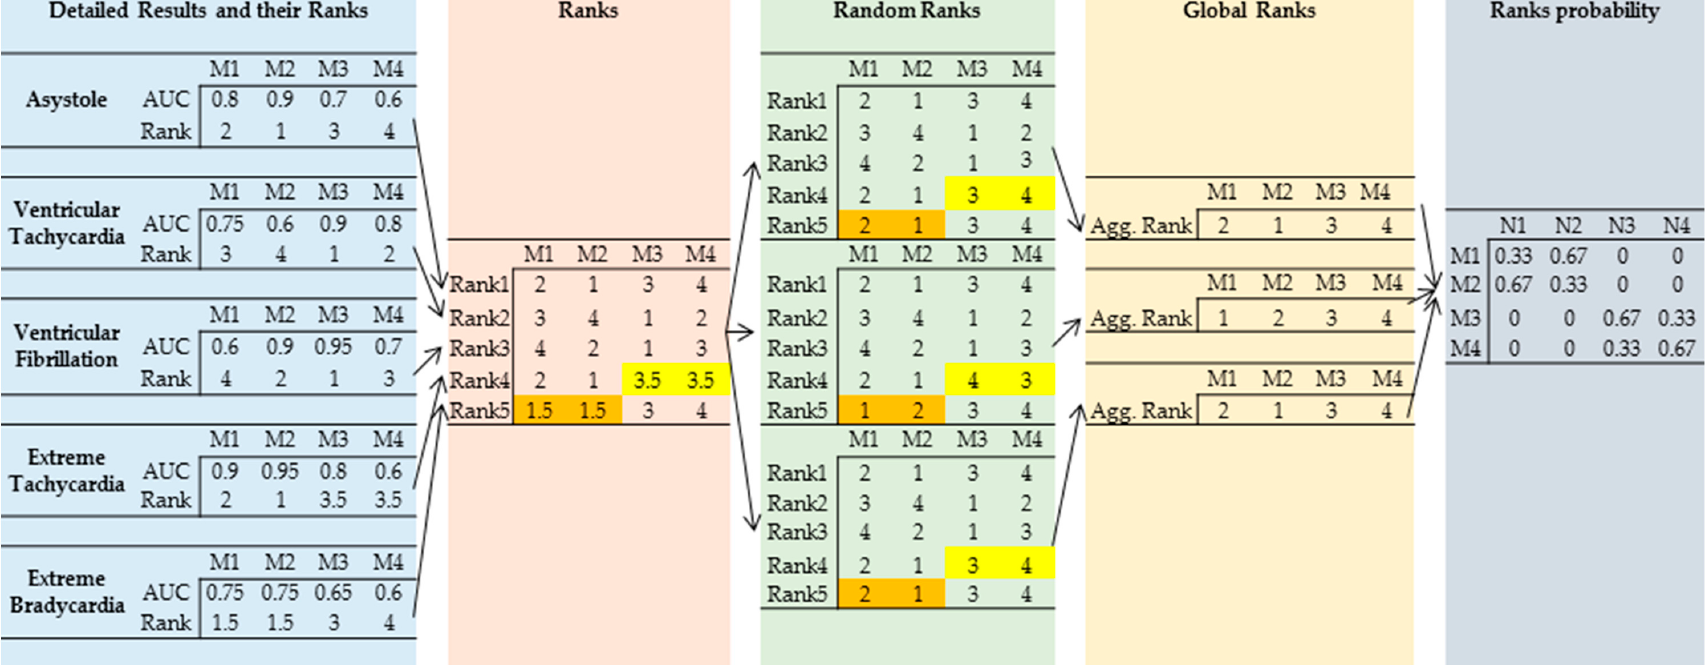
Figure A1. The approach to derive global ranks (N1–N4) for each method (M1–M4) for probability assignment and each arrhythmia type based on the AUC measure on the validation sample. Orange and yellow highlight the equal ranks; these were subject to 3 ‐ fold random rank assignment.